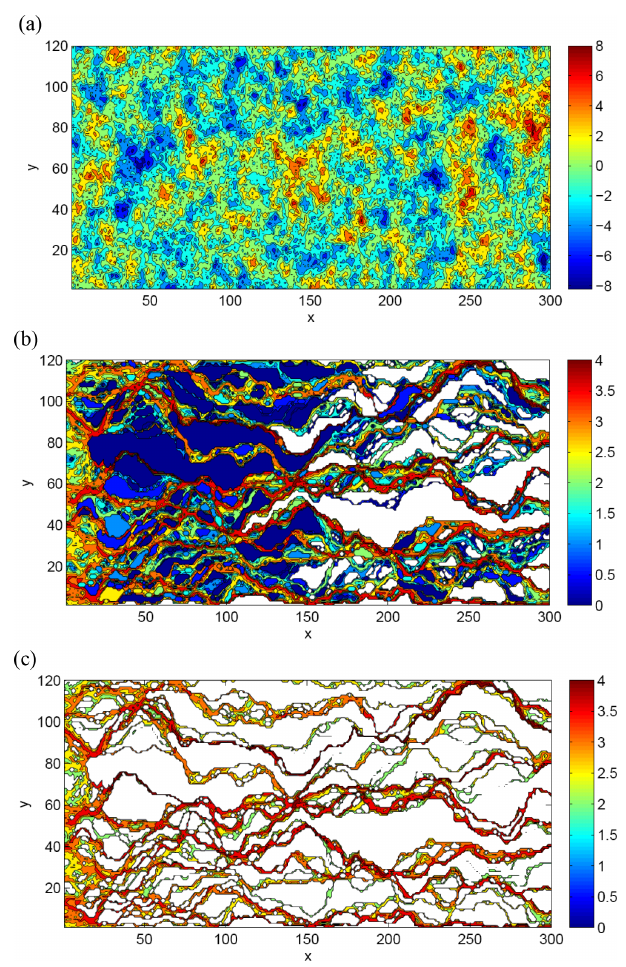
Figure 4. (a) Spatial map showing a sample hydraulic conductiv- ity ( K ) field generated statistically (right side bar shows scale of ln (K) ). (b) Spatial map showing particle paths through the domain, for overall hydraulic gradient (water flow) from left to right. “Par- ticles” representing dissolving chemical species are injected along the left vertical boundary and followed through the domain. White regions indicate where no particles “visit” (interrogate) the domain. Blue regions have only a small number of particle visitations. Red regions have significant particle visitations. Note that the colour bar is in log10 number of particles. (c) Spatial map showing preferen- tial particle paths, defined as paths through cells (underlying sub- divisions in the domain, each with a different K value as shown in panel a above) that each contain a “visitation” of a minimum of 0.1% of the total number of particles in the domain. Note that the colour bar is in log10 number of particles (after Edery et al., 2014; © with permission from the American Geophysical Union